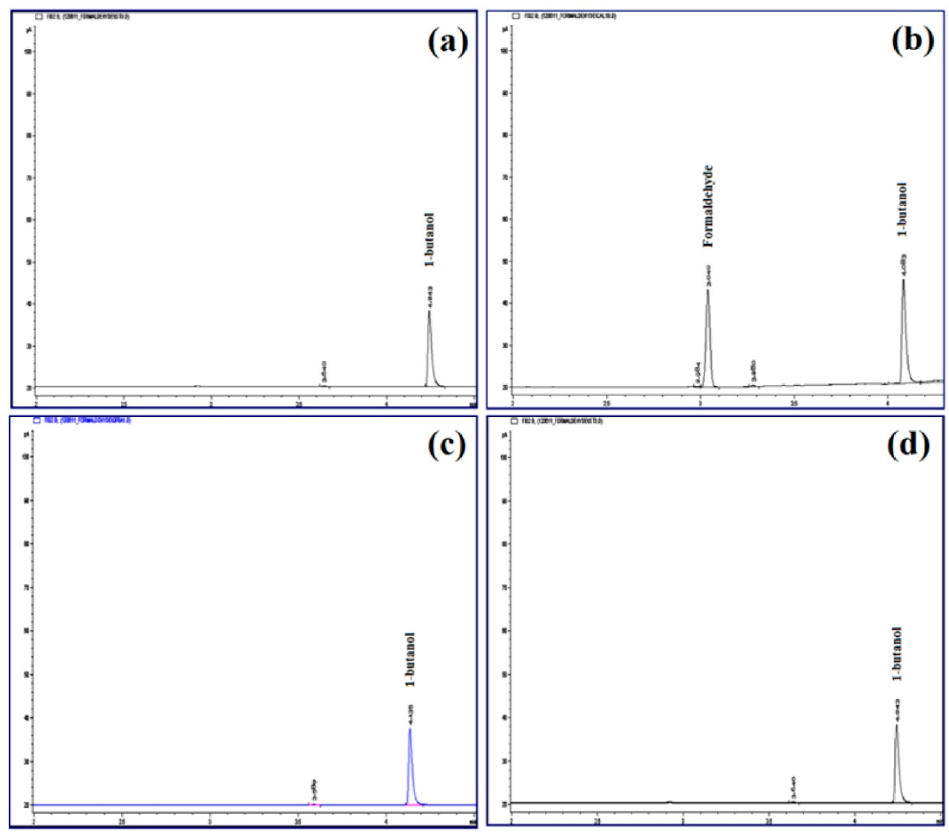
Figure 12. Chromatograms of formaldehyde analysis by gas chromatography: ( a ) blank solution, ( b ) internal standard solution of 1-butanol, ( c ) standard solution containing 0.1% formaldehyde and 1-butanol, and ( d ) cross-linked CPM.